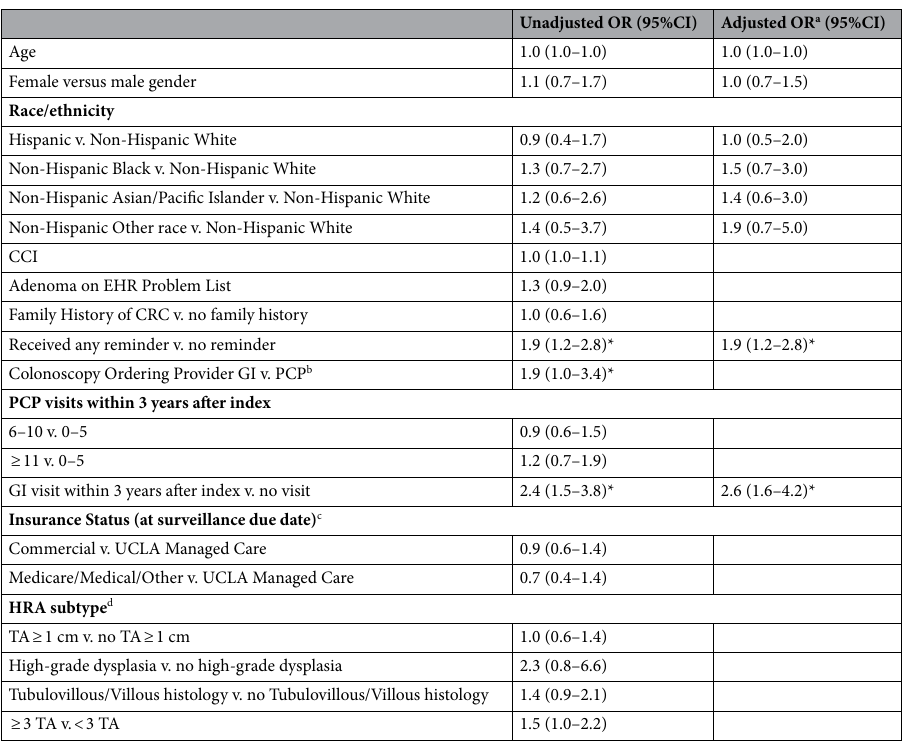
Table 2. Crude and adjusted odds ratios of surveillance colonoscopy completion at 3.5 years; n = 405. CI confidence interval; CCI Charlson Comorbidity Index; EHR electronic health record; CRC colorectal cancer; GI gastroenterologist; OR odds ratio; PCP primary care physician; HRA high risk adenoma; TA tubular adenoma. a For adjusted models, we included age, gender, race/ethnicity, and variables significant at the P < 0.05 level in univariate analyses. b Total n = 280 patients with a colonoscopy order. Because only 69.1% of patients had a colonoscopy order, this variable was not included in the multivariable logistic regression. c Among patients with insurance n = 386. d HRA subtypes are not mutually exclusive. *Denotes statistical significance at the P < 0.05